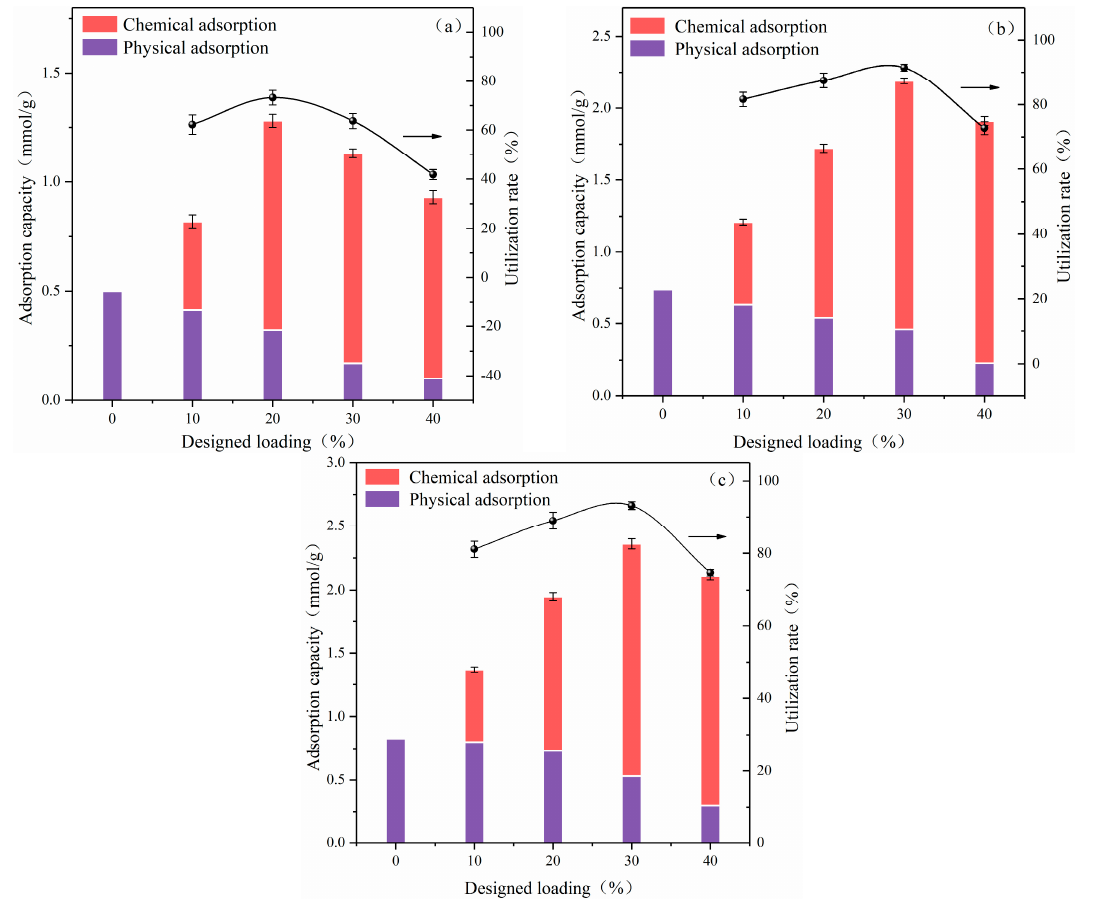
Figure 6. Adsorption capacity of K 2 CO 3 -based adsorbent under 80% N 2 + 10% CO 2 + 10% H 2 O ( a ) Al-B, ( b ) Al/Si, ( c ) Al/Si-TMCS.